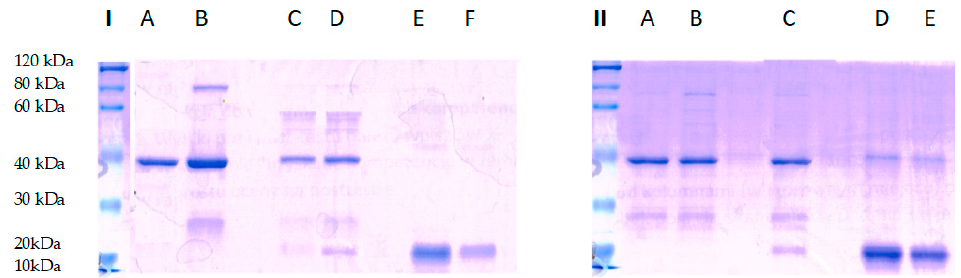
Figure 4. SDE-PAGE analysis of RANK-RANKL complex stabilization. I test system: Line A—RANKL protein control, Line B—RANKL after column washing; Line C—complex destruction after 24h